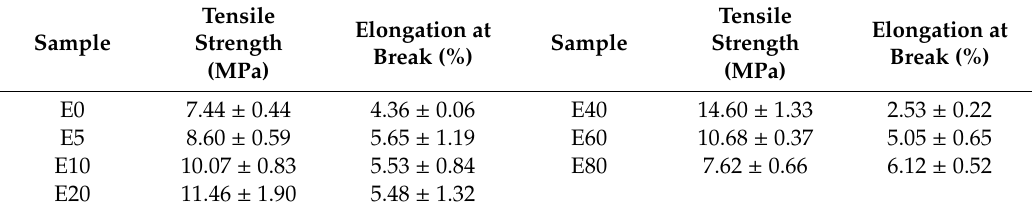
Table 2. Tensile test results of the modified hemicellulose